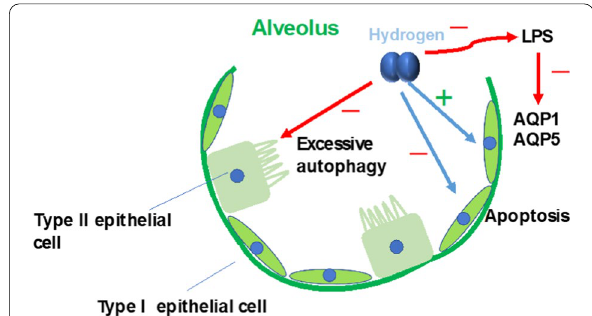
Fig. 2 Protective effects of molecular hydrogen on AECs. Molecular hydrogen alleviates AEC apoptosis, decreasing the inhibitory effect of LPS on AQP1 and AQP5, and protects type II AECs in LPS-induced injury by inhibiting excessive